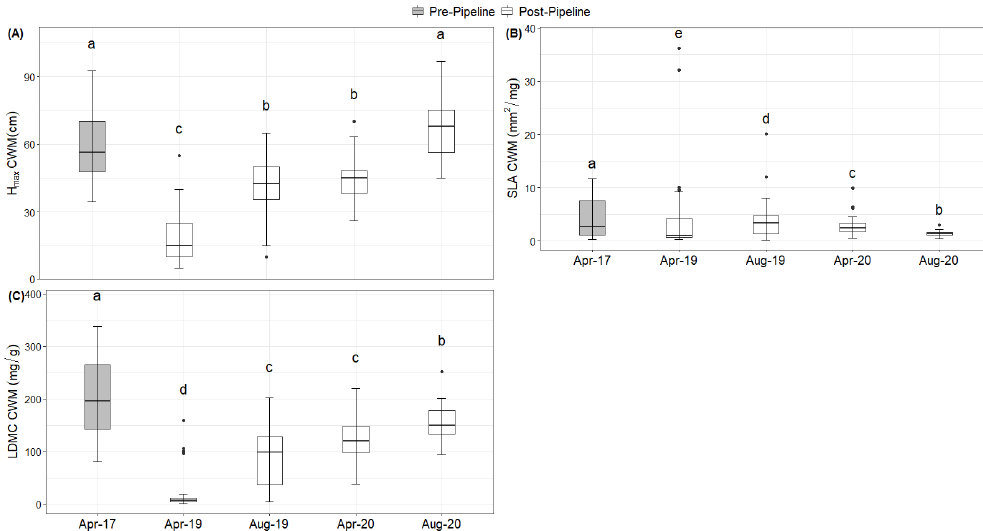
Figure 4. Differences in the community-weighted means of the plant functional traits for the five sampling events (before and after the megaproject) in ( A ) maximum plant height (H max ), ( B ) specific leaf area (SLA), and ( C ) leaf dry matter content (LDMC). Letters above the boxes indicate significant differences based on Tukey’s HSD at the p < 0.05 threshold.